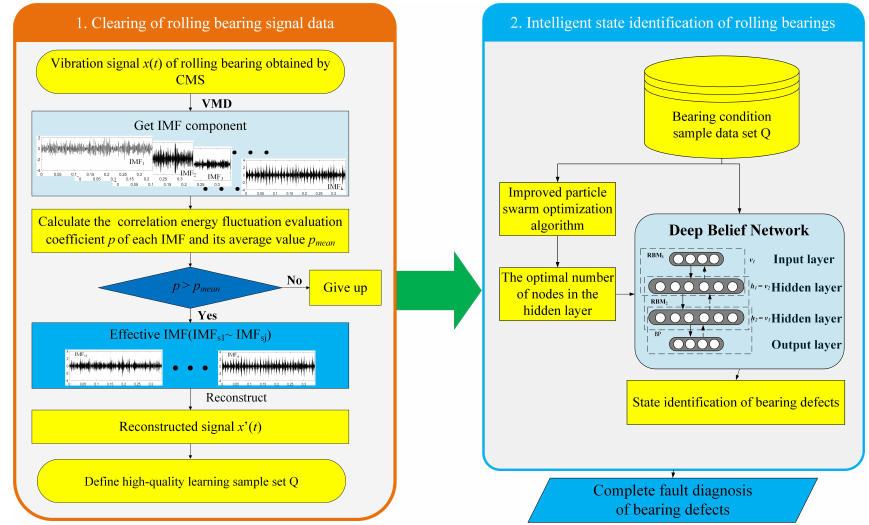
Figure 1. Flow chart of bearing intelligent identification